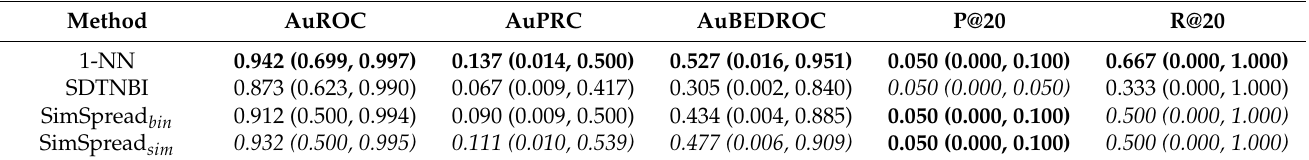
Figure 4. Predictive performance comparison of four methods in time-split validation. Boxplots for ( A ) AuROC, ( B ) AuPRC, ( C ) AuBEDROC, ( D ) P@20, and (E) R@20 obtained in the time-split validation on the ChEMBL24 → 28 dataset for 1-NN, NBI, SDTNBI, SimSpread bin and SimSpread sim using ECFP4 molecular descriptor and Tanimoto coefficient as similarity measure. For SimSpread variants, the similarity cutoff α is equal to 0.2. Boxplot notch represents the bootstrapped 95% CI around the median, the white dot represents the mean, and whiskers correspond to 1.5 × IQR. Table 1. Predictive performance comparison of the studied methods in time-split